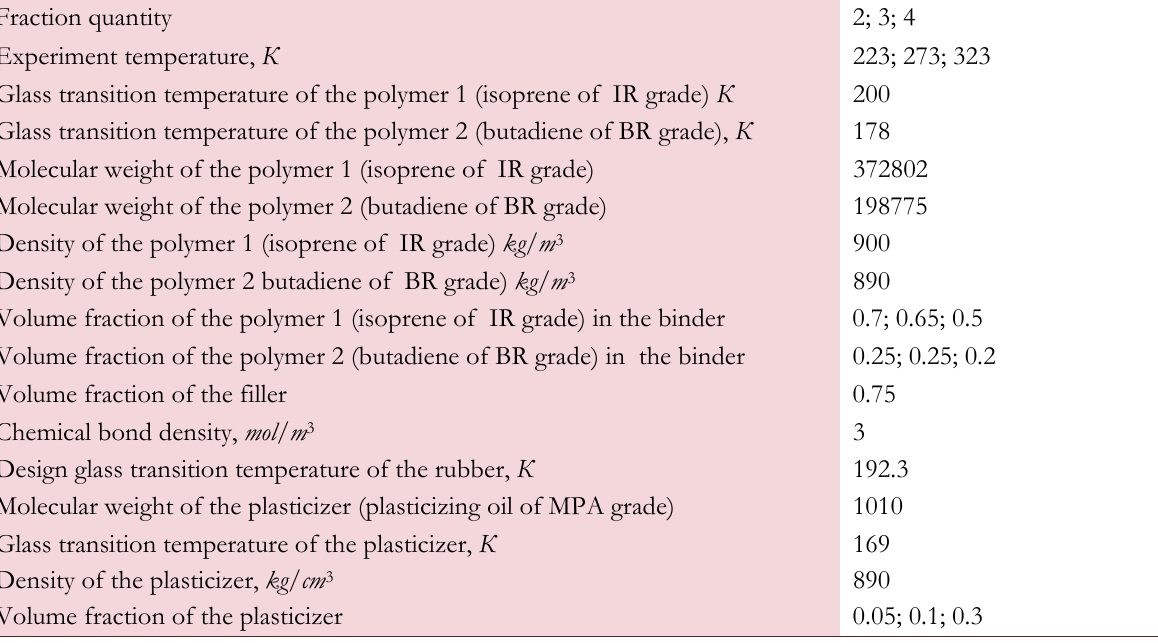
Table 2: Data required for numerical